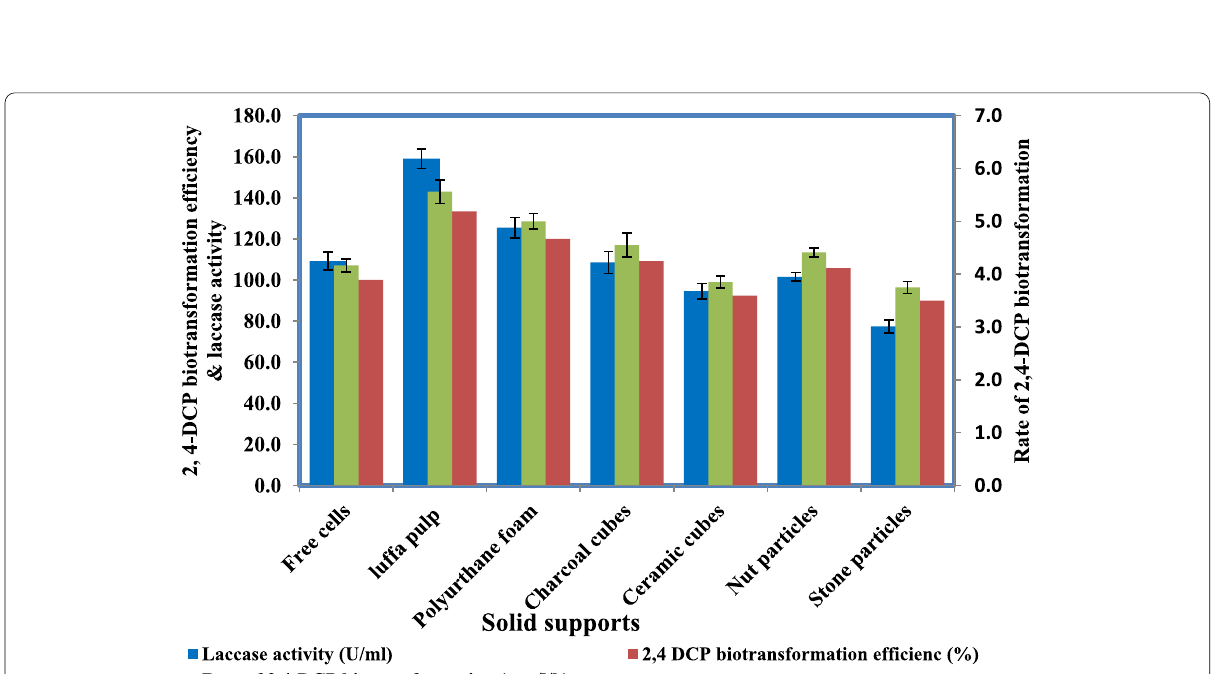
Fig. 1 Biotransformation of 2,4‑DCP by B. subtilis AAK entrapped cells of with different gel materials. Data are represented as mean technical replicates ( n